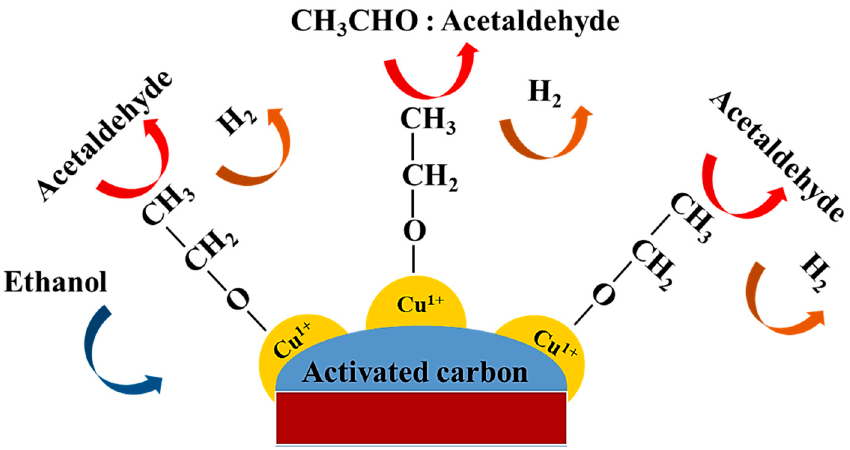
Scheme 1. A proposed mechanism for the dehydrogenation reaction of ethanol on Cu/ACC catalyst.